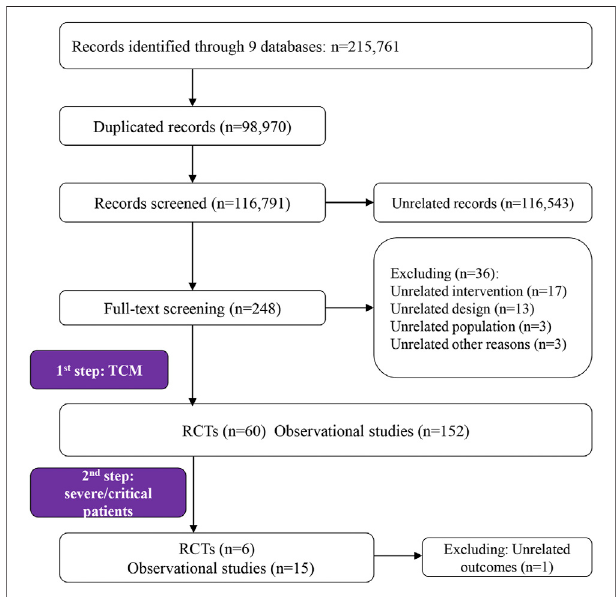
FIGURE 1 | Study selection PRISMA fl ow